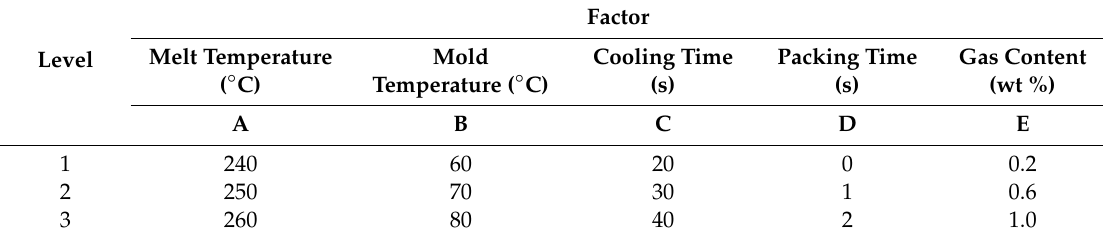
Table 3. Design of experiments.